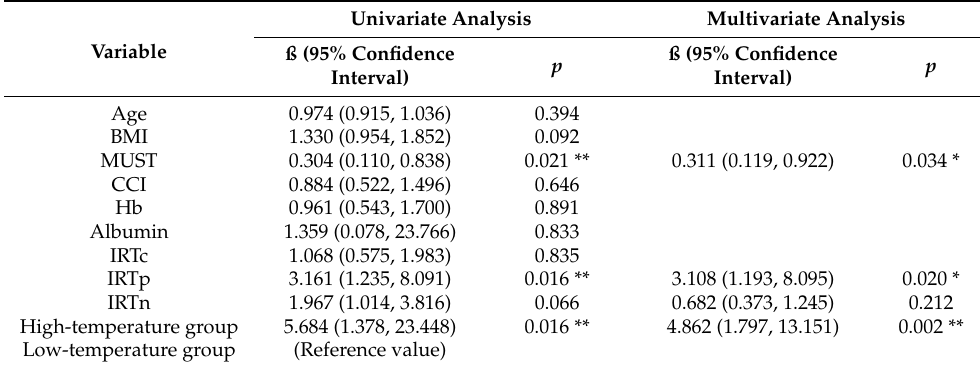
Table 4. Factors associated with poor wound-healing (increased PUSH score) after three days ( n = 248).